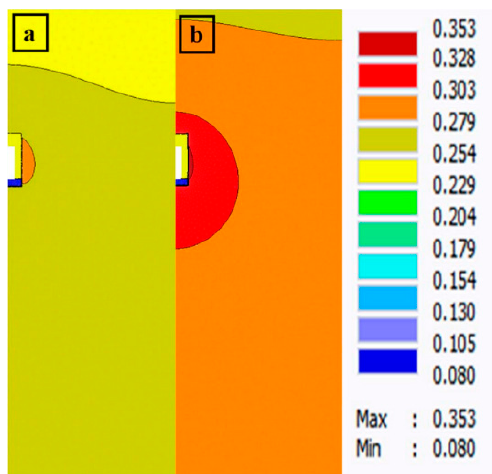
Figure 7. Wetting front for a ceramic emitter buried in sandy loam and PAM mixed sandy loam after 120 h ( a . Sandy loam; b , Sandy loam with water retaining agent).